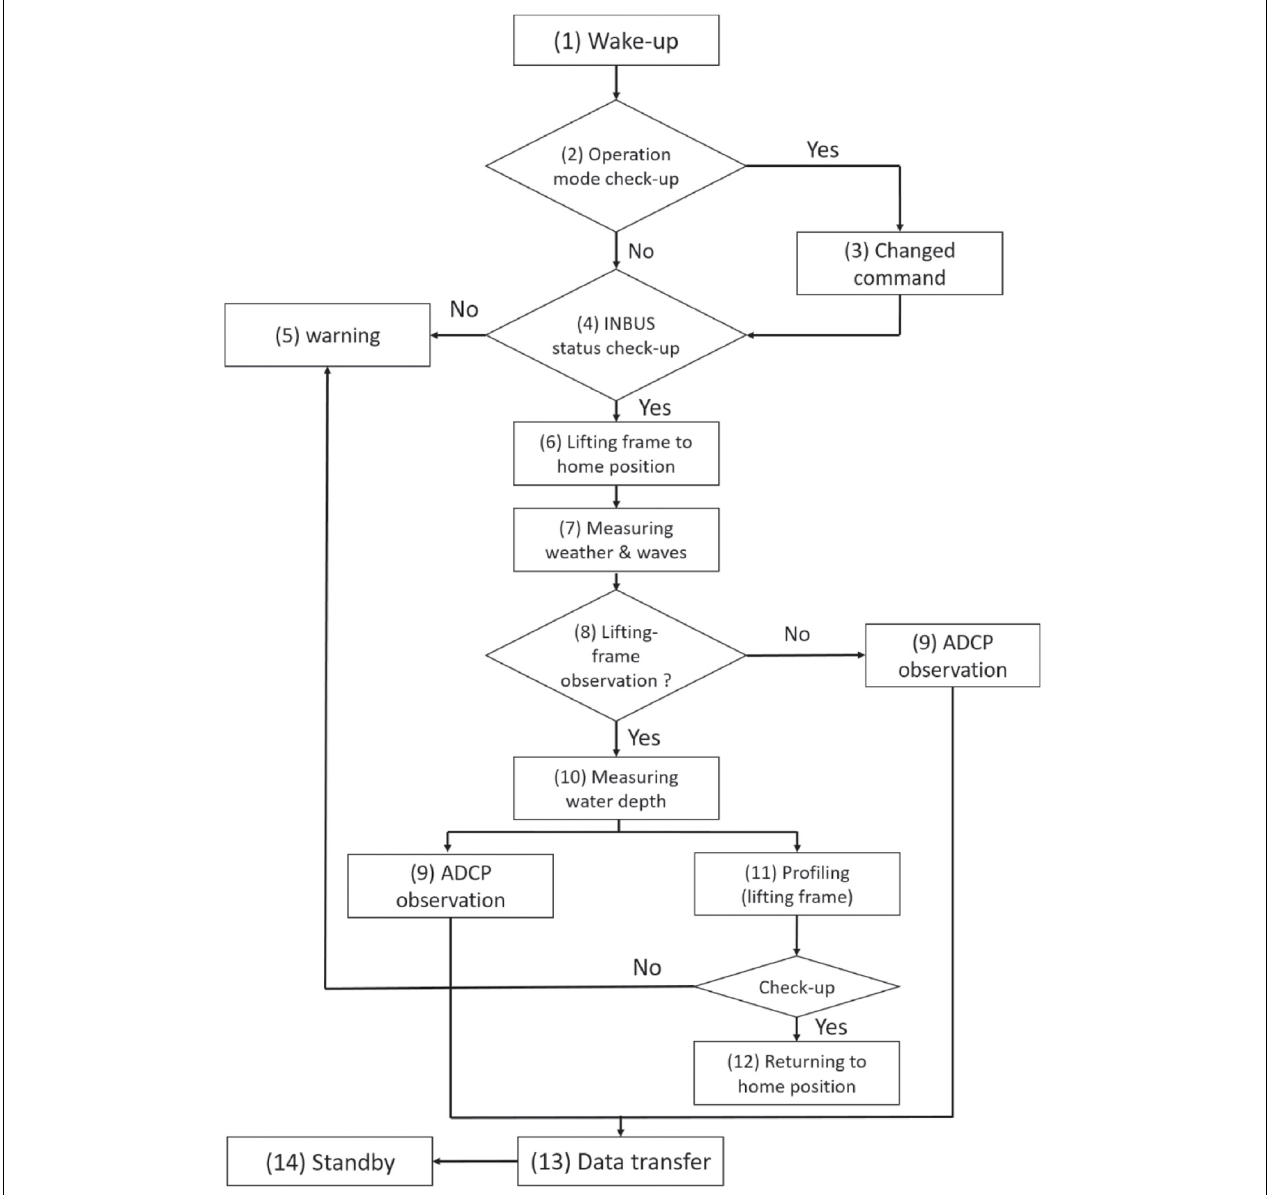
FIGURE 5 | Flowchart of INBUS-2 operation